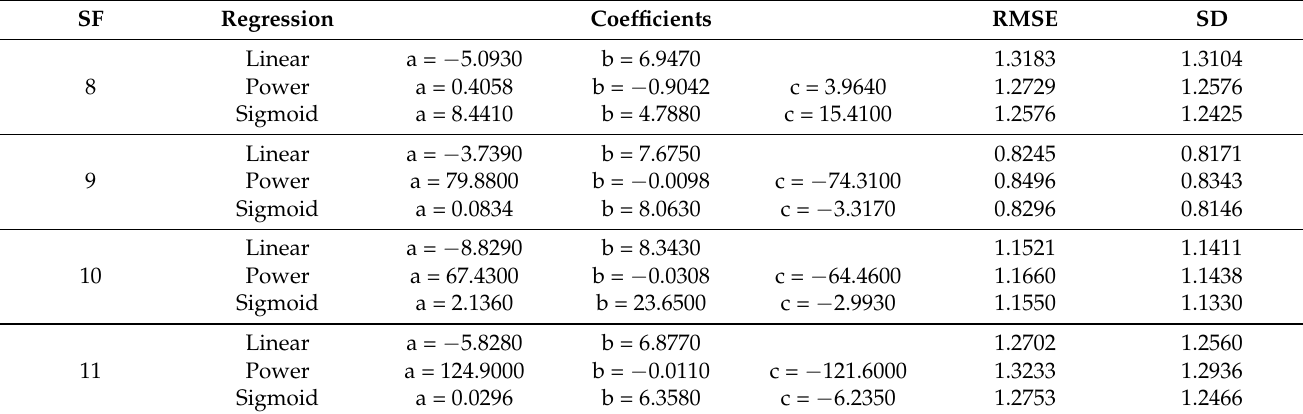
Table 3. RMSE values for uplink regression at 42 m